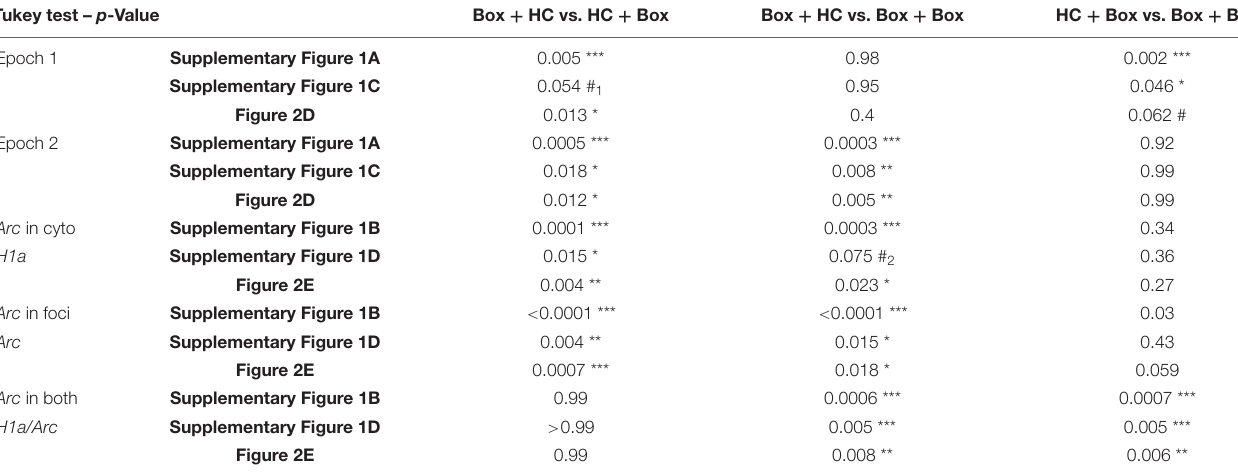
TABLE 2 | Comparisons between pairs of groups (Tukey tests) for Figure 2 and Supplementary Figure 2